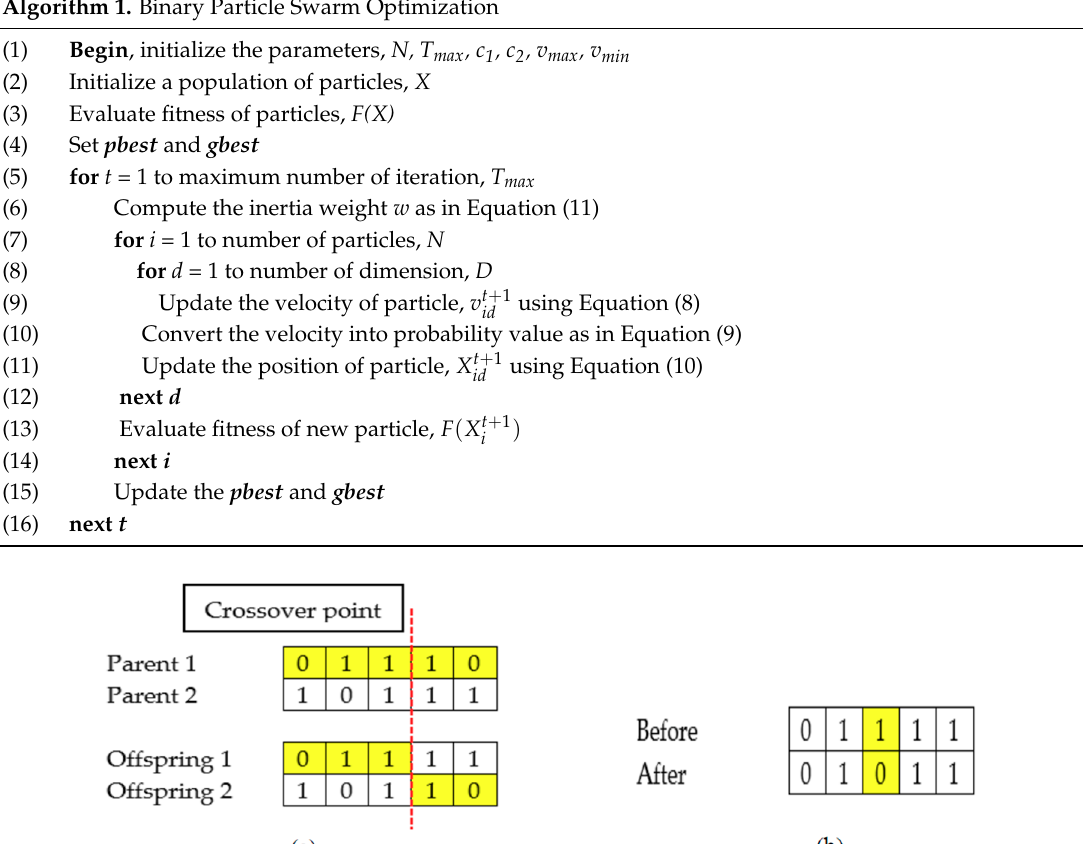
Algorithm 1. Binary Particle Swarm Optimization